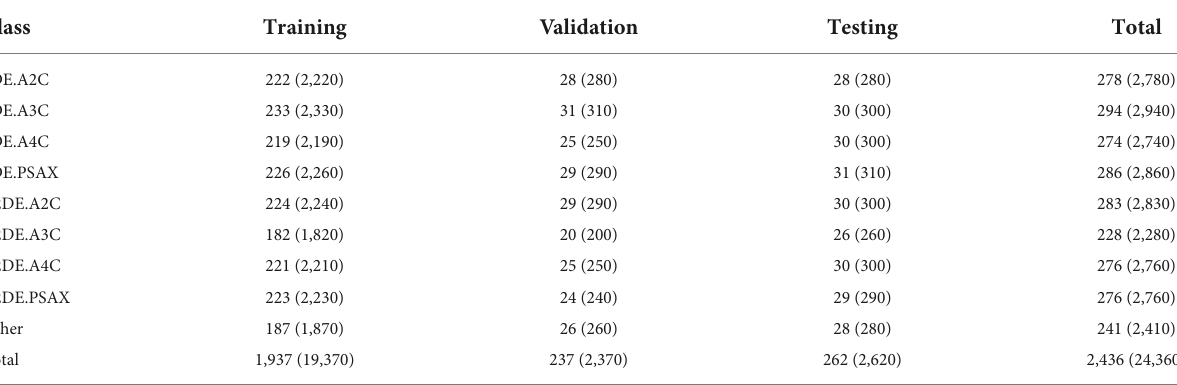
TABLE 2 Distribution of the clip number in the